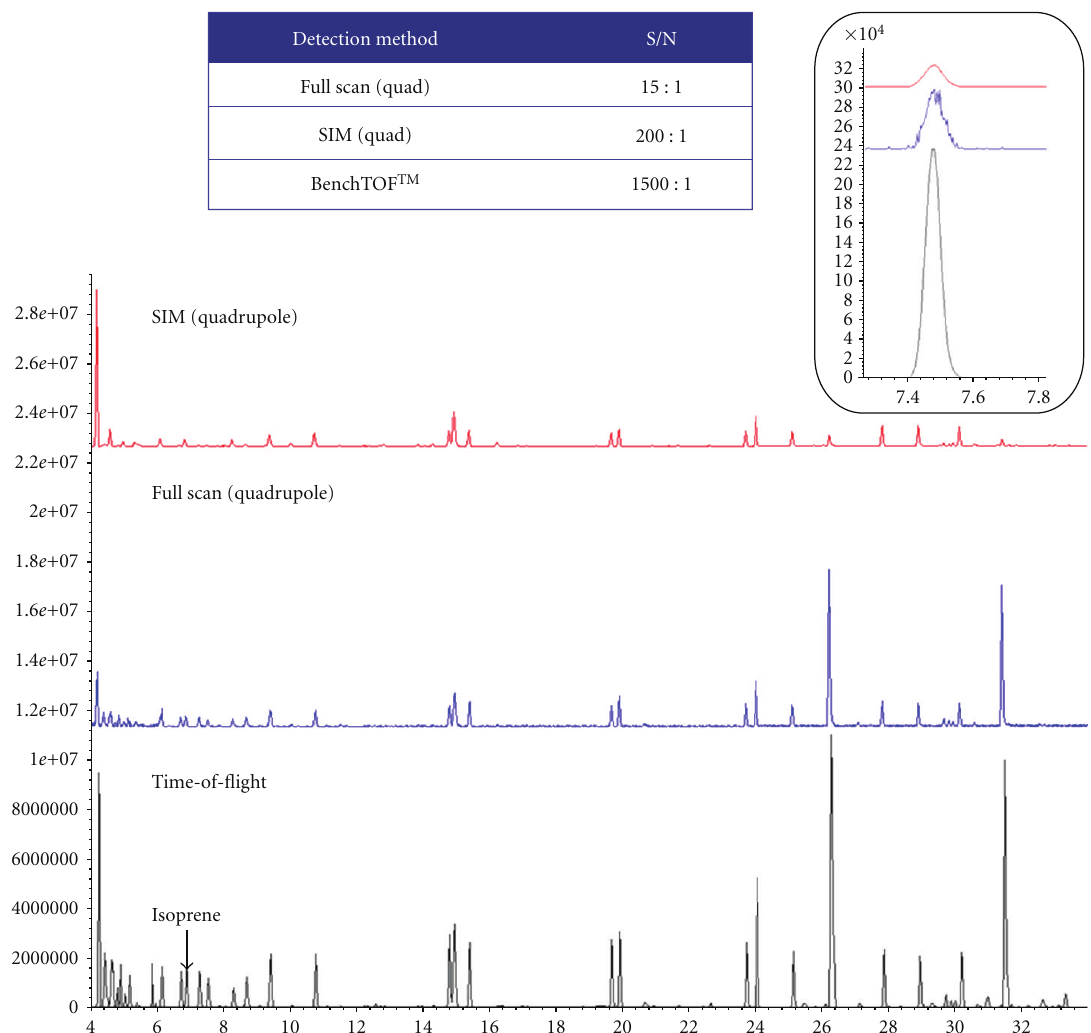
FIGURE 11: 500 mL of a 4 ppb level hydrocarbon standard collected on a multi-bed tube using a piston pump and analysed by TD-GC/MS (TD-100, Markes International Ltd), using a quadrupole mass spectrometer (full scan, blue; SIM, red) and a TOF mass spectrometer (black—BenchTOF-dx ALMSCO International Ltd, UK). Table inset shows the root-mean-square (RMS) signal-to-noise ratio (S/N) for isoprene using the ion at m/z 67. The inset shows extracted-ion m/z 67 for 260 pg of isoprene on column, showing excellent peak shape and a signal-to-noise ratio for TOF MS implying a detection limit for isoprene of (cid:3) 10 ppt under the conditions used. Method conditions are shown in Table 10.